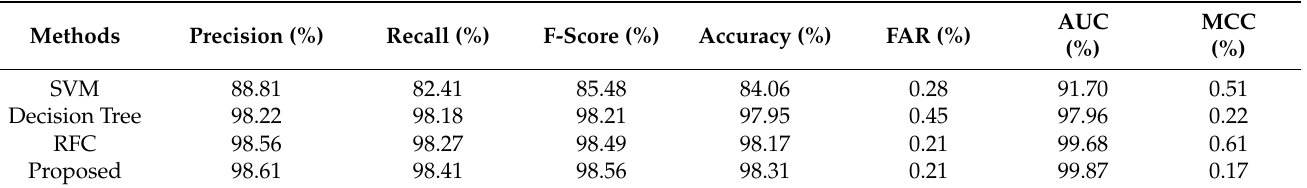
Table 2. Performance evaluation for the proposed SMO-HPSO for NSL-KDD dataset to binary attack